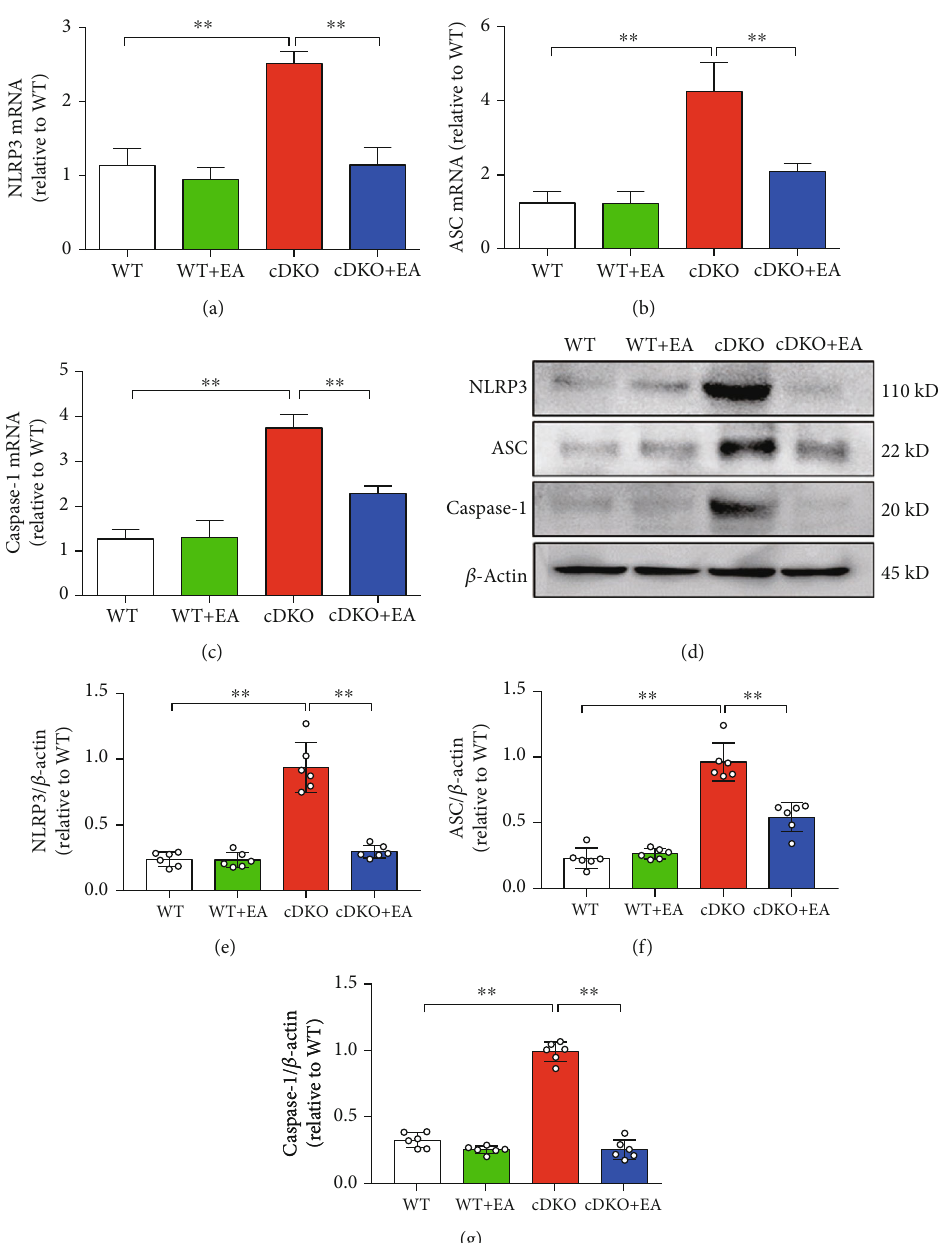
Figure 4: EA treatment reverses the robust upregulated levels of NLRP3 in fl ammasome in the hippocampus of PS cDKO mice. (a) – (c) Total RNA was isolated and subjected to quantitate the mRNA levels of NLRP3, ASC, and caspase-1 in the hip by qRT-PCR ( n = 5 mice for each group). The mRNA levels were standardized based on the respective level of β -actin. Values were expressed as relative changes to WT mice, which was set to 1. (d) Representative Western blot of NLRP3, ASC, and caspase-1 in the hippocampus. (e) – (g) Quanti fi cation of Western blot for NLRP3, ASC, and caspase-1 in the hippocampus ( n = 6 mice for each group). The protein levels of NLRP3, ASC, and caspase-1 were normalized with the levels of β -actin. The values were expressed as relative changes to the respective WT mice, which was set to 1. Data are the mean ± S : E : M : , ∗ p < 0 : 05 , ∗∗ p < 0 : 01